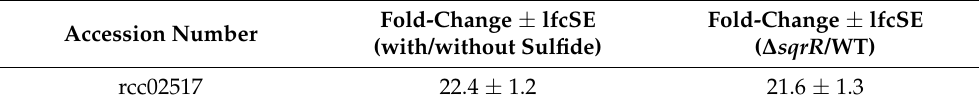
Table 2. Effects of sulfide and loss of SqrR on levels of trxC gene transcription in WT bacteria. Data are cited from